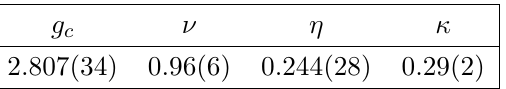
Table 1 . The values of the critical coupling g c , the critical exponents (cid:23) , (cid:17) and the 2-point function normalization (cid:20) at the critical point as de(cid:12)ned in eq. (1.4), found in this paper. The exact values of the exponents are (cid:23) = 1 and (cid:17) = 1 = 4